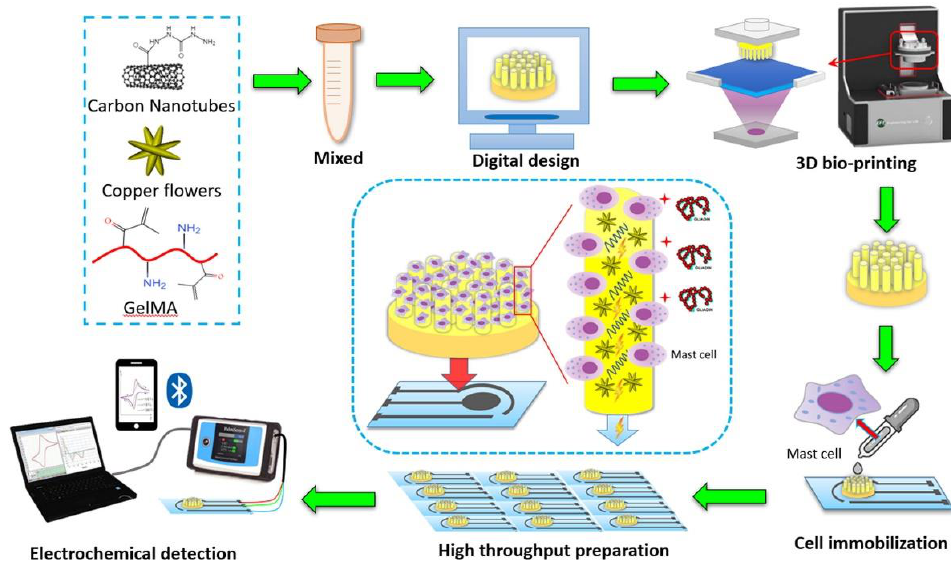
Figure 16. Schematic diagram of the assembly and detection procedures of the cell-based electro- chemical sensor for gliadin detection. Reprinted with permission from [163]. Copyright 2021, Else-